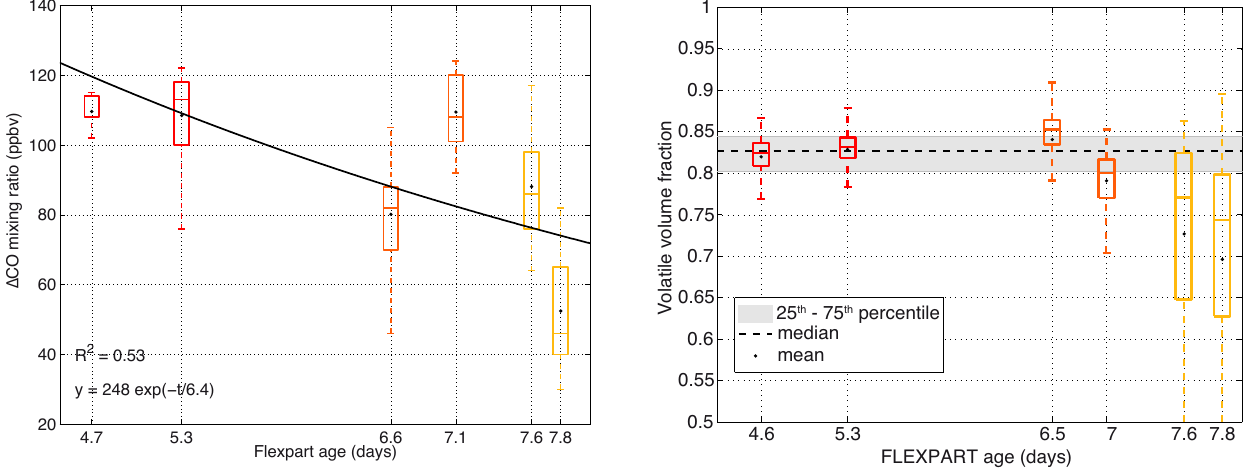
Fig. 7b. Presentation of aerosol F volatile as a function of the FLEX- PART derived age of air masses. The mean volatile volume fraction for the 6 flight segments is plotted in